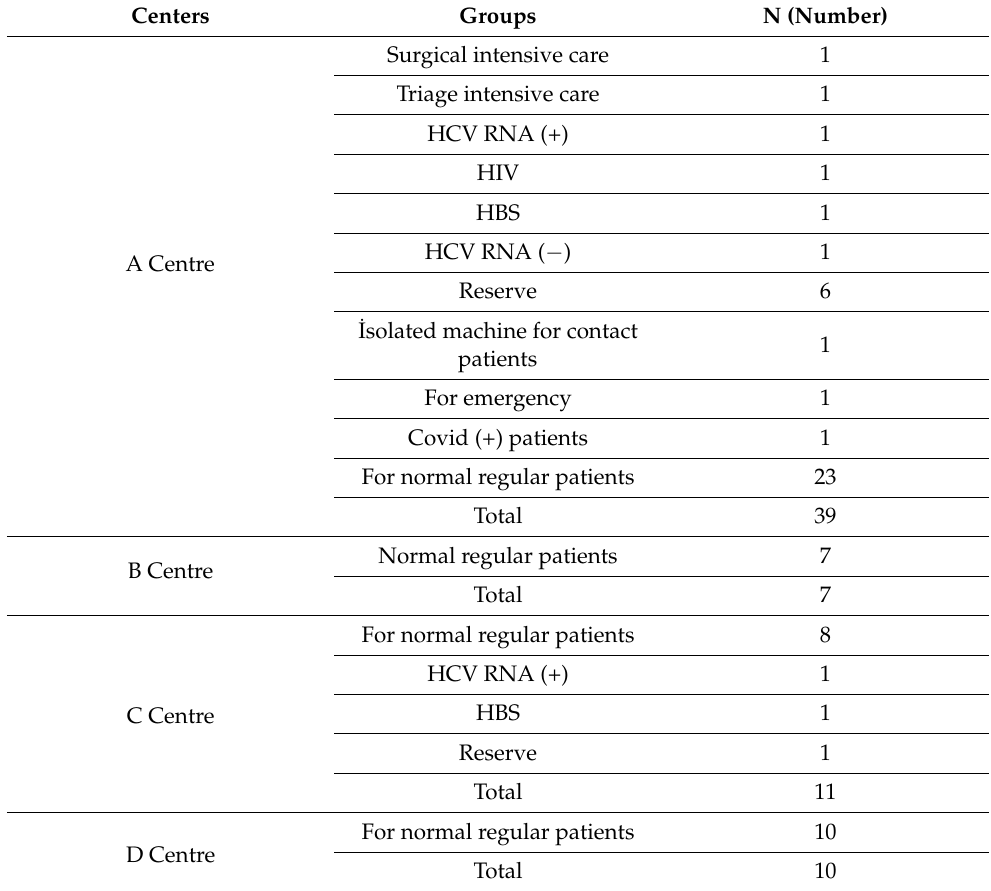
Table 2. Dialysis machines capacity of dialysis centres in 2020.